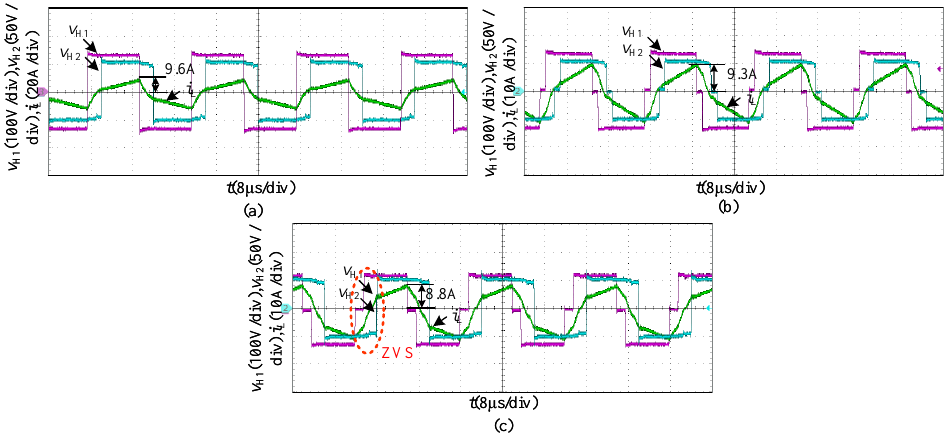
Figure 7. Steady-state waveforms of different control strategies under heavy load: ( a ) the SPS control strategy, ( b ) the current-stress optimization control strategy of DPS control, ( c ) the MUOC strategy.